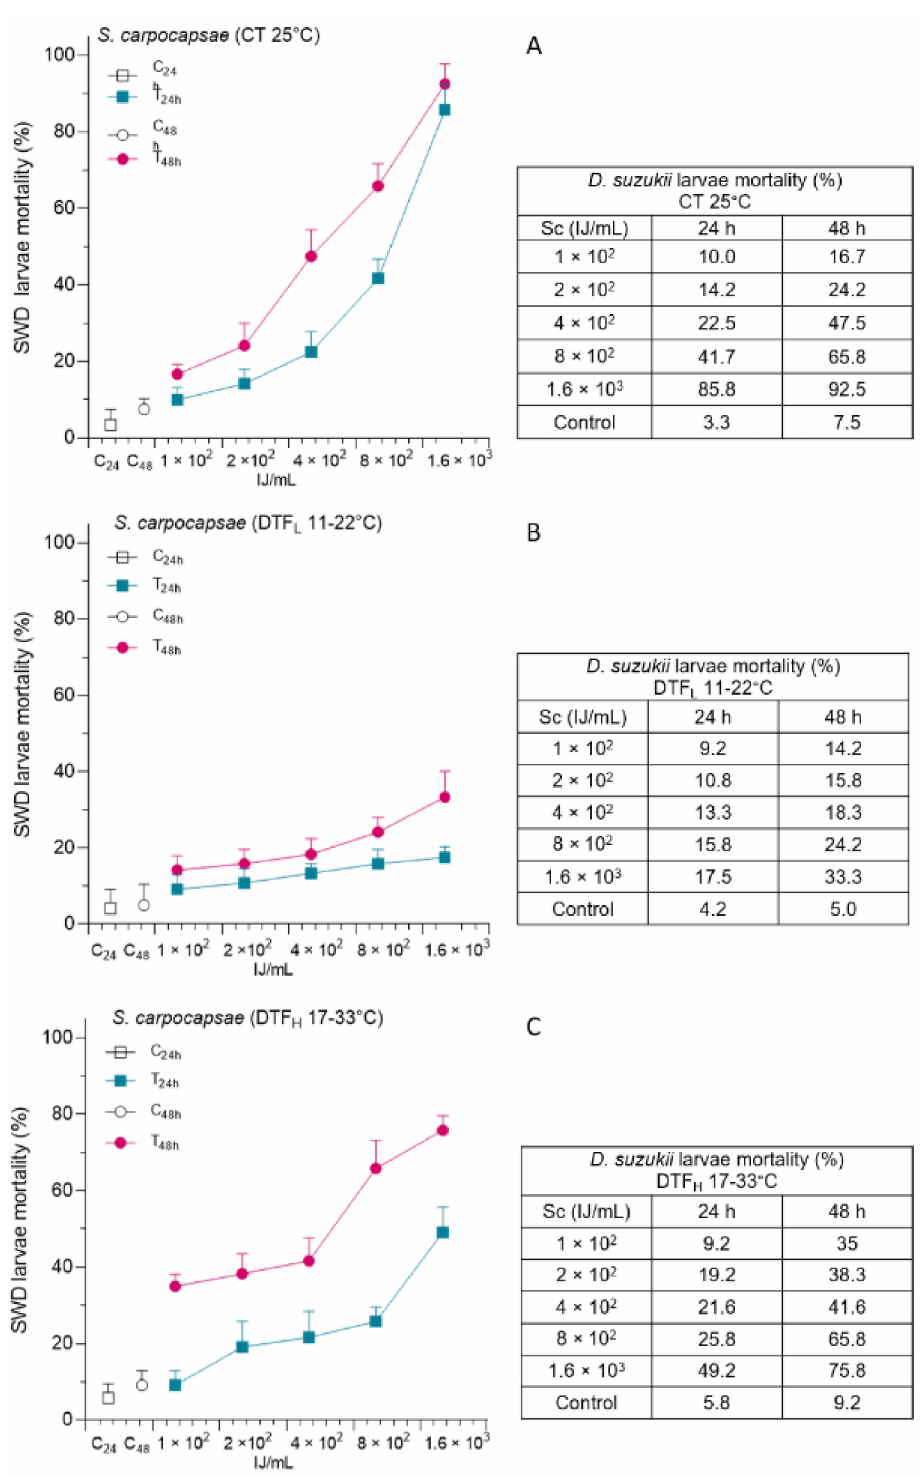
Figure 2. The efficacy of Steinernema carpocapsae (Sc), at increasing concentrations, was evaluated as percentage mortality of Spotted Wing Drosophila (SWD) larvae (mean plus standard deviation), at 24 and 48 h, under constant temperature—CT 25 ◦ C ( A ), low-temperature fluctuation—DTF